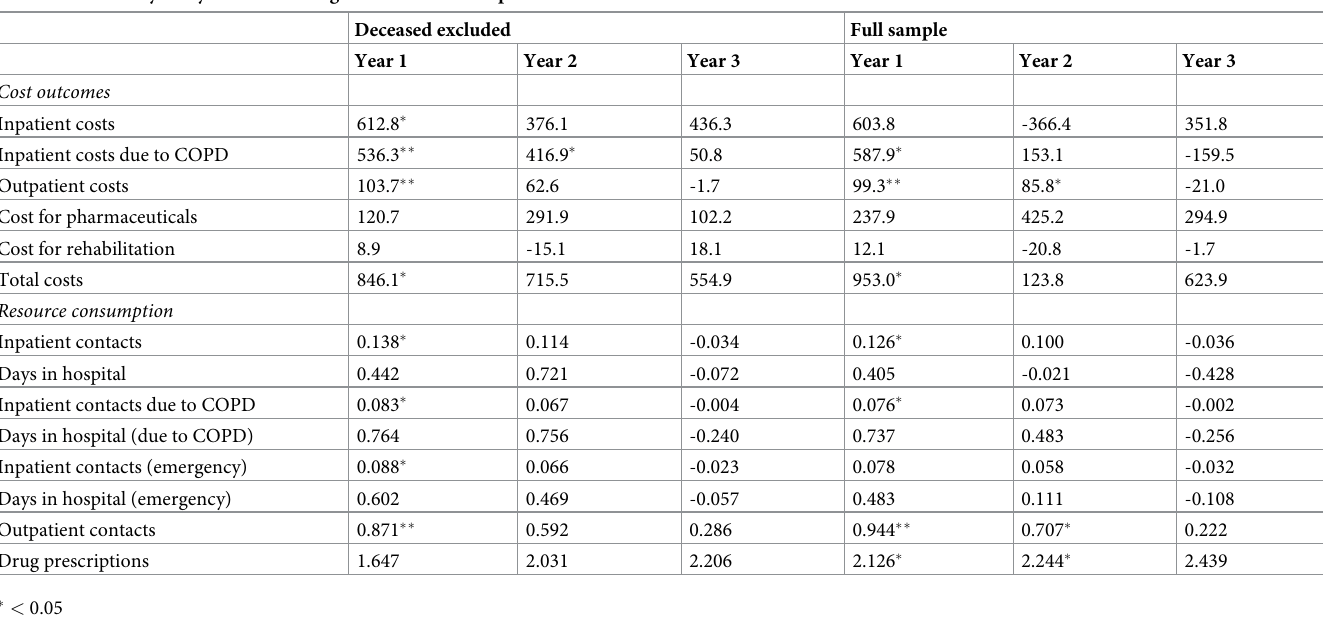
Table 4. Sensitivity analysis II: Excluding deceased / full